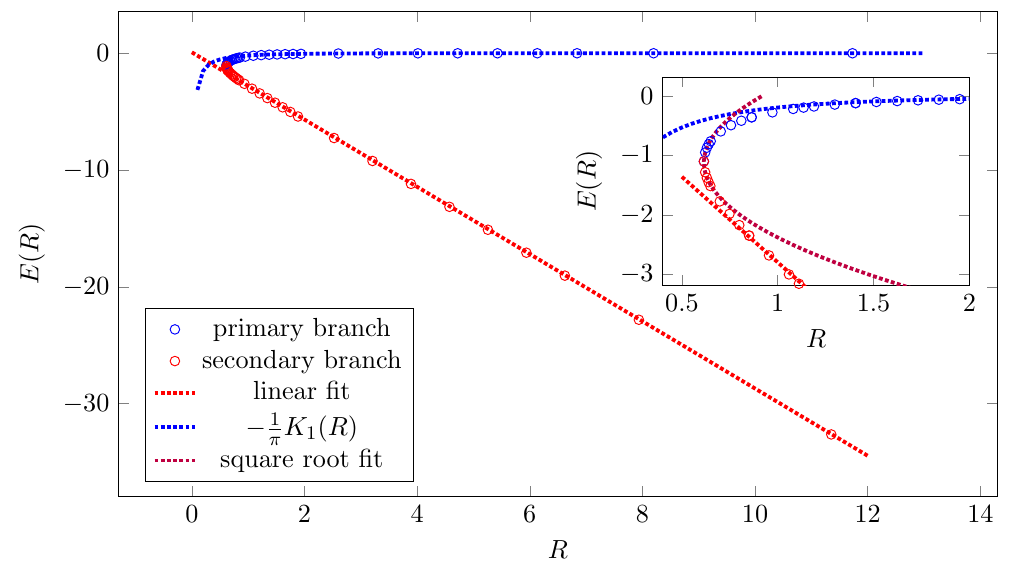
Figure 5. Here is plotted the ground-state energy E ( R ) for the model with S -matrix (3.11) with θ 0 = 1 / 2 and γ = 3 π/ 20 , obtained through the PALC routine described in section 4. The numerical points are sided by three lines, approximating E ( R ) for large R on both branches and for R & R